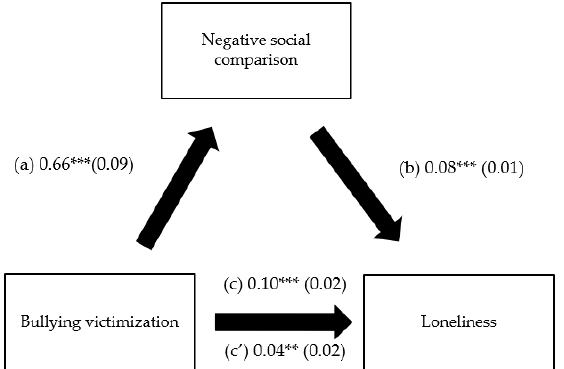
Figure 2. ( a ) Relation between bullying victimization and negative social comparison (R 2 = 0.160); ( b ) Relation between negative social comparison and loneliness (R 2 = 0.328); ( c ) total effect of the relation between bullying victimization and loneliness (R 2 = 0.154); ( c’ ) direct e ff ect of the relation between bullying victimization and loneliness. Numbers are displayed as regression coe ffi cients (standard error). *** p < 0.001; ** p < 0.01.